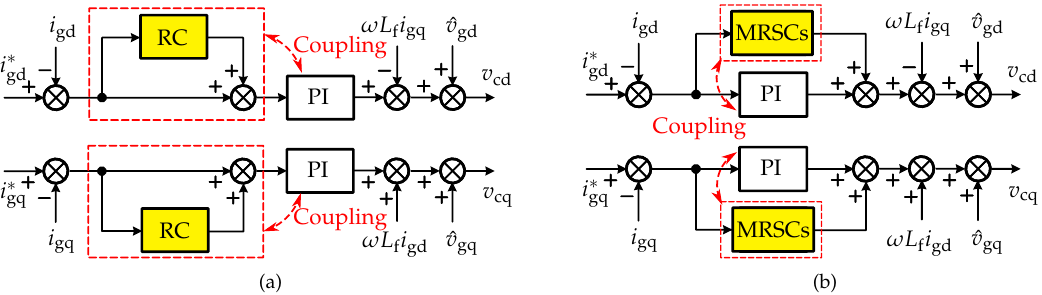
Figure 2. Compensation scheme ( a ) Traditional compensation scheme based on the plug-in RC ( b ) Traditional compensation scheme based on the MRSCs.